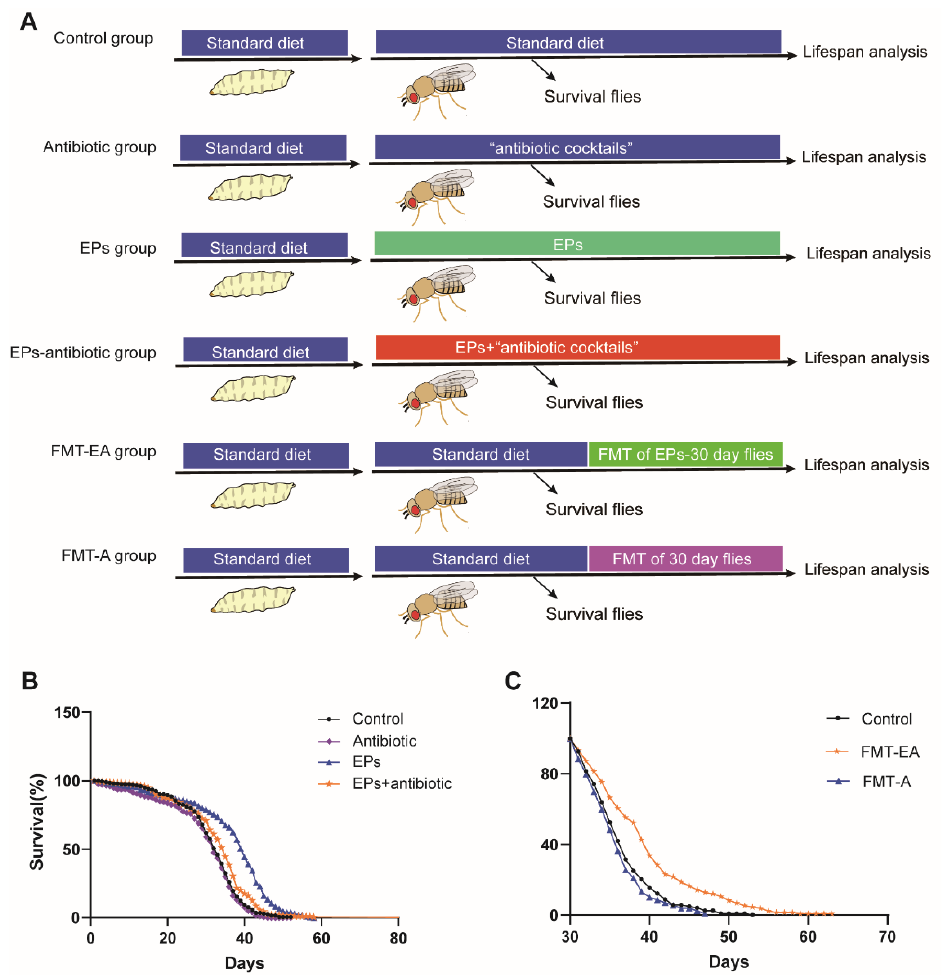
Figure 6. Life - extending effect of EPs achieved via gut microbiota remodeling. ( A ) Outline of the experimental strategy. ( B ) Percentage survival of the control group, antibiotic group, EP+antibiotic group , and EP groups. ( C ) Percentage survival of the control group, FMT - EA group (cultured on the dirty medium in which the 30 - day - old flies in EP groups were cultured for 3 days) , and FMT - A group (cultured on the dirty medium in which the 30 - day - old flies in the control group were cultured for 3 days). Mean ± SEM ( n = 200). The details of the statistical tests used in this figure are given in the Section 4 . Table 3. Statistics of survival curves in Figure 6 . Cohort sizes, mean and median life spans, percentage changes, and log - rank tests of the Kaplan – Meier survival curves in this study.